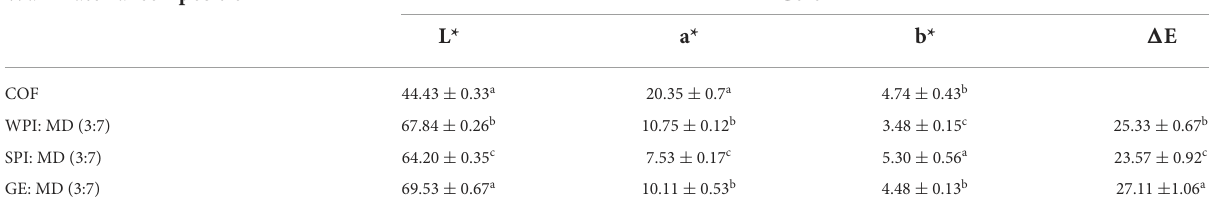
TABLE 3 Color parameters of microcapsules.